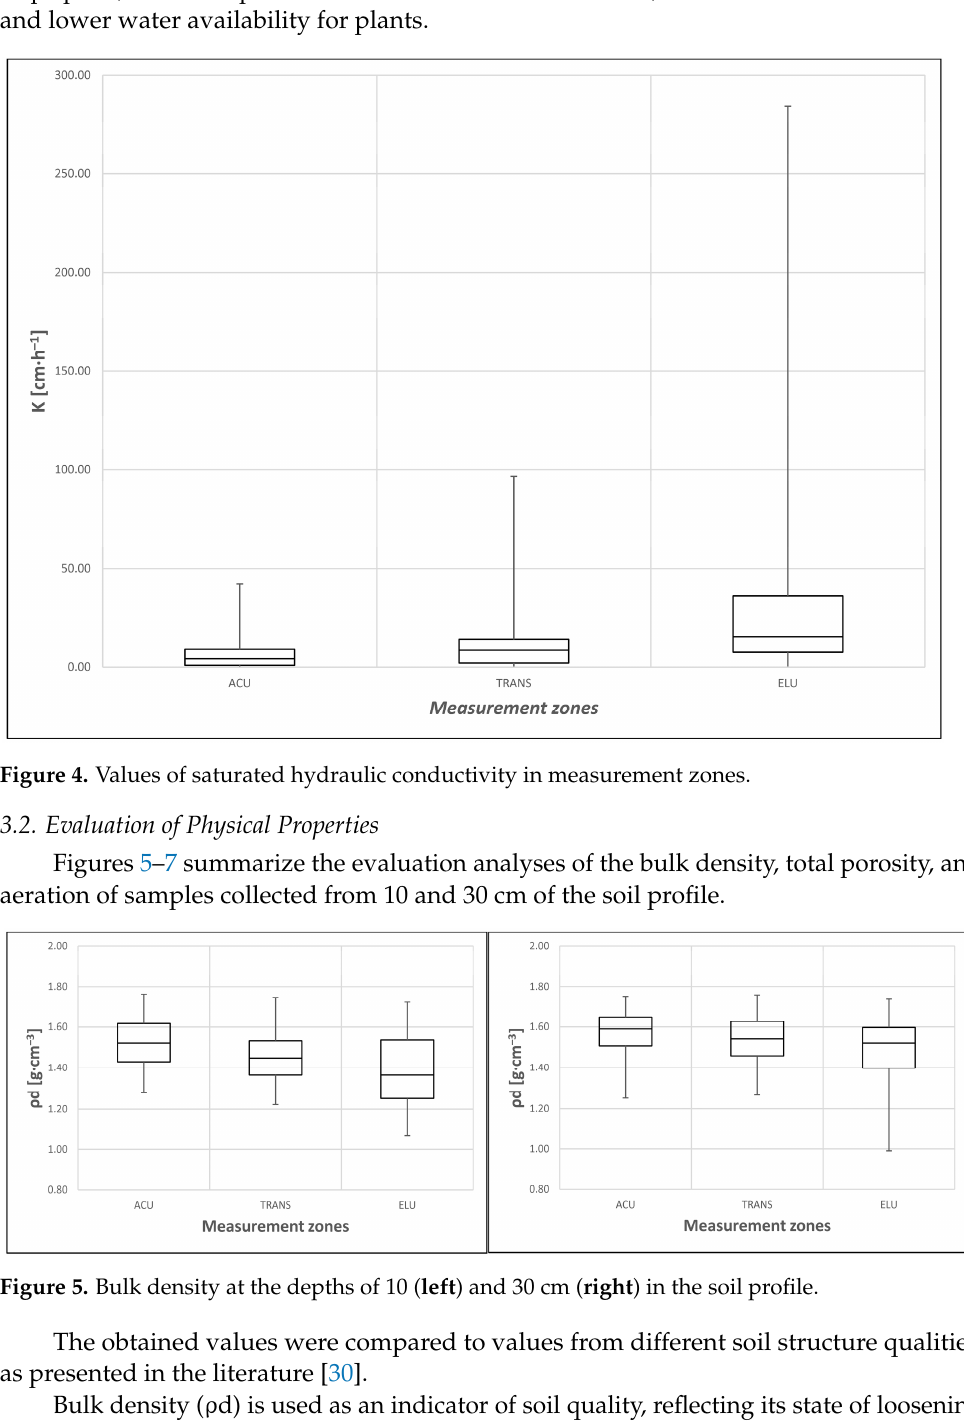
Figure 5. Bulk density at the depths of 10 ( left ) and 30 cm ( right ) in the soil profile. The obtained values were compared to values from different soil structure